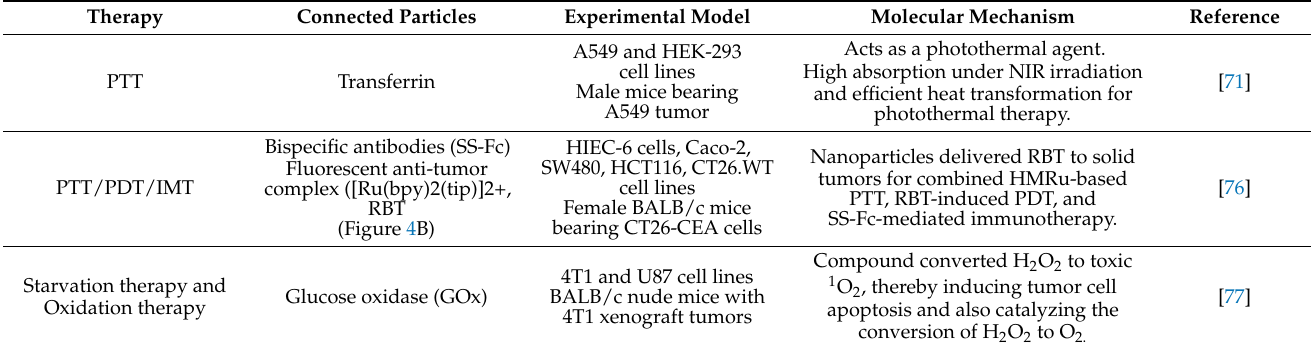
Table 7. Selected connections of biologically active molecules with ruthenium